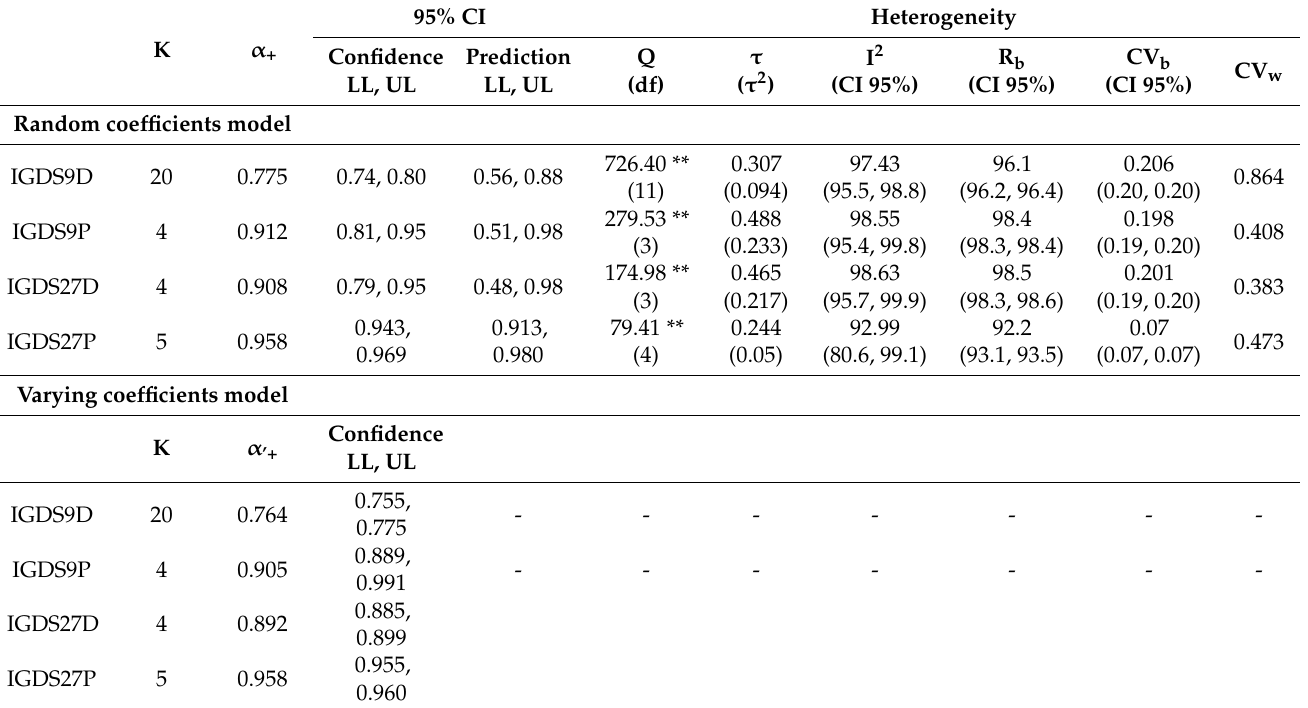
Table 2. Meta-analytical